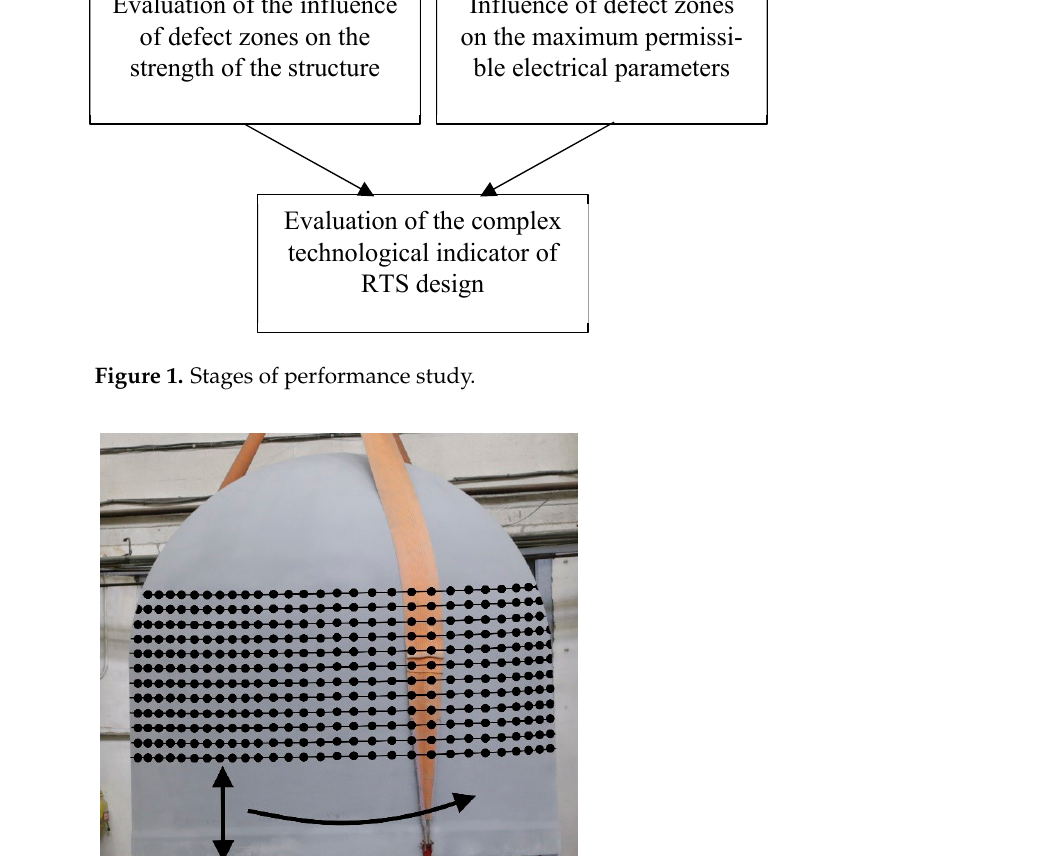
Figure 2. Example of the considered shape of the fairing, with schematically plotted points for measuring the magnitude of EMW energy losses.